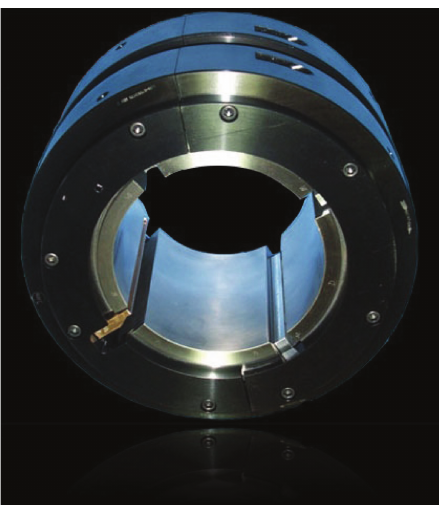
Figure 1: Tilting pad journal